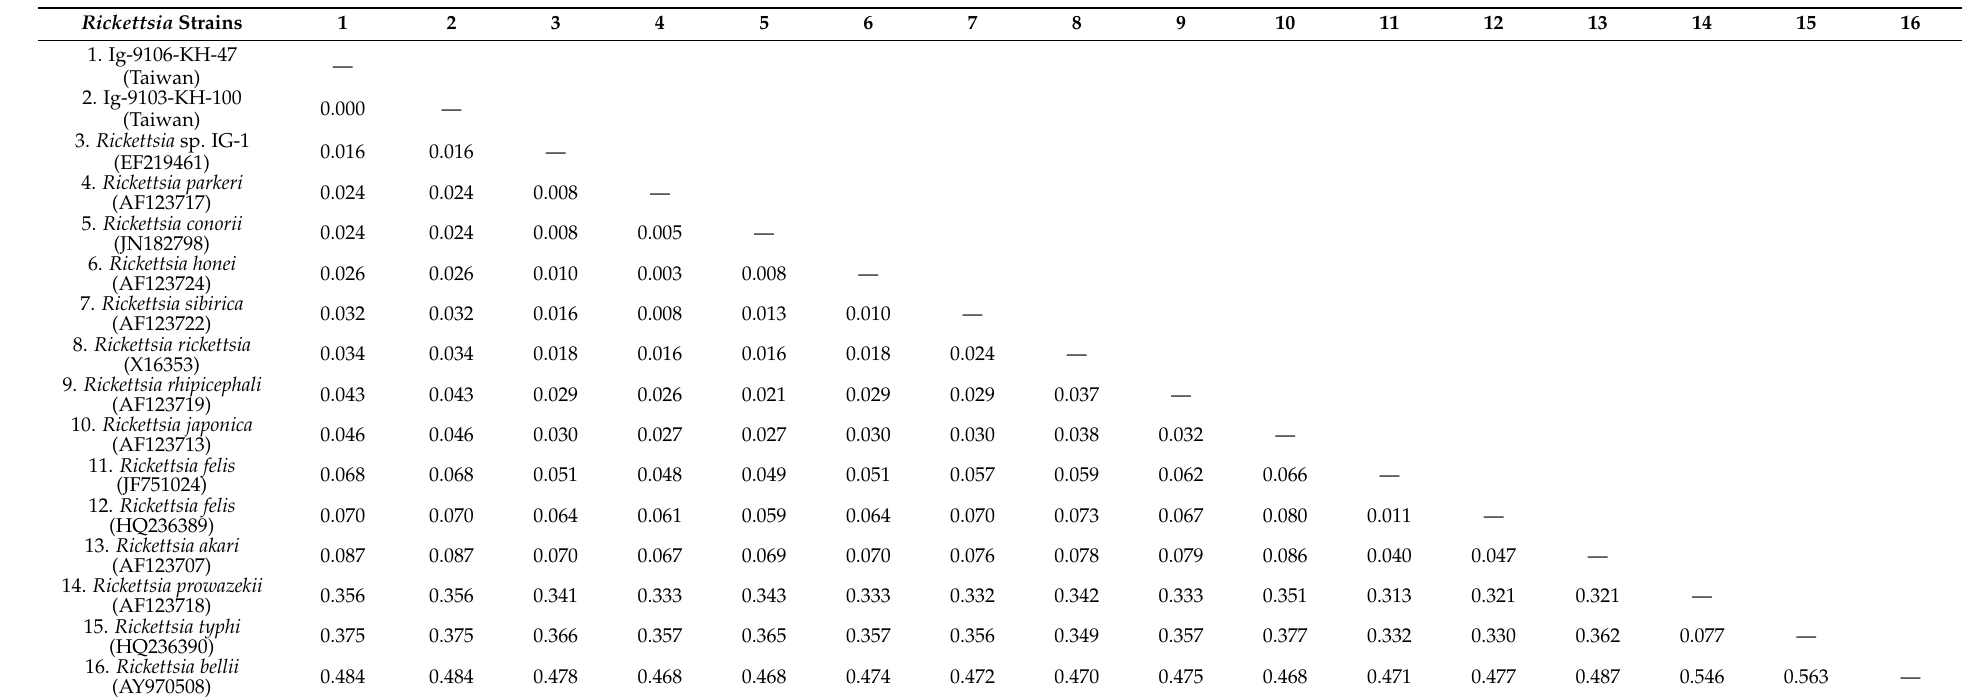
Table 4. Intra- and inter-species analysis of genetic distance values a based on the ompB gene sequences between Rickettsia strains of Taiwan and other strains of Rickettsia documented in